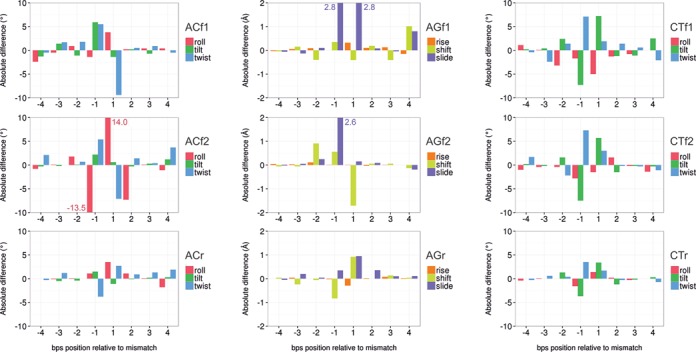
Lesion information transfer. Structural distortions induced by the MMs on the neighboring base pairs steps (bps) for selected MM in different environment (f1, f2, r, see Figure 1). The absolute difference was obtained by subtracting the average value of a given helical parameters and a given bps in the MM simulation to the same helical parameter and bps in the canonical simulations. Note that the sequence is referred relative to the MM base pair (position 0). Translational (angstroms) and rotational (degrees) helical parameters are displayed separately. The Lesion information transfer for all the other MMs are reported in SI, Figures S11–S13.